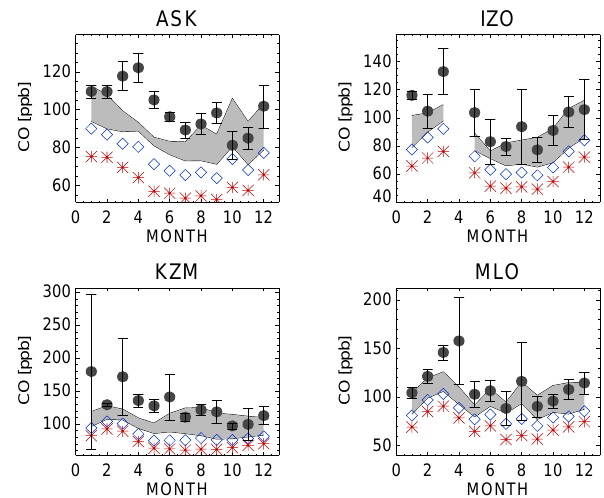
Fig. 9. Comparisons of monthly mean CO mixing ratios at various high altitude measurement sites from the GMD measurement net- work, along with the 1- σ variability in the ensemble mean (shaded grey area) and the corresponding monthly means from the NOB- VOC (blue diamonds) and NOISOPTERP (red asterisks) simu- lations. The sites shown are Assekrem, Algeria (ASK, 23.2 ◦ N, 5.4 ◦ E; 2728m), Tenerife (IZO, 28.3 ◦ N, 16.5 ◦ W; 2360m), Plateau Assy (KZM, 43.3 ◦ N, 77.9 ◦ E; 2519m) and Mauna Loa, Hawaii (MLO, 19.5 ◦ N, 155 ◦ W;